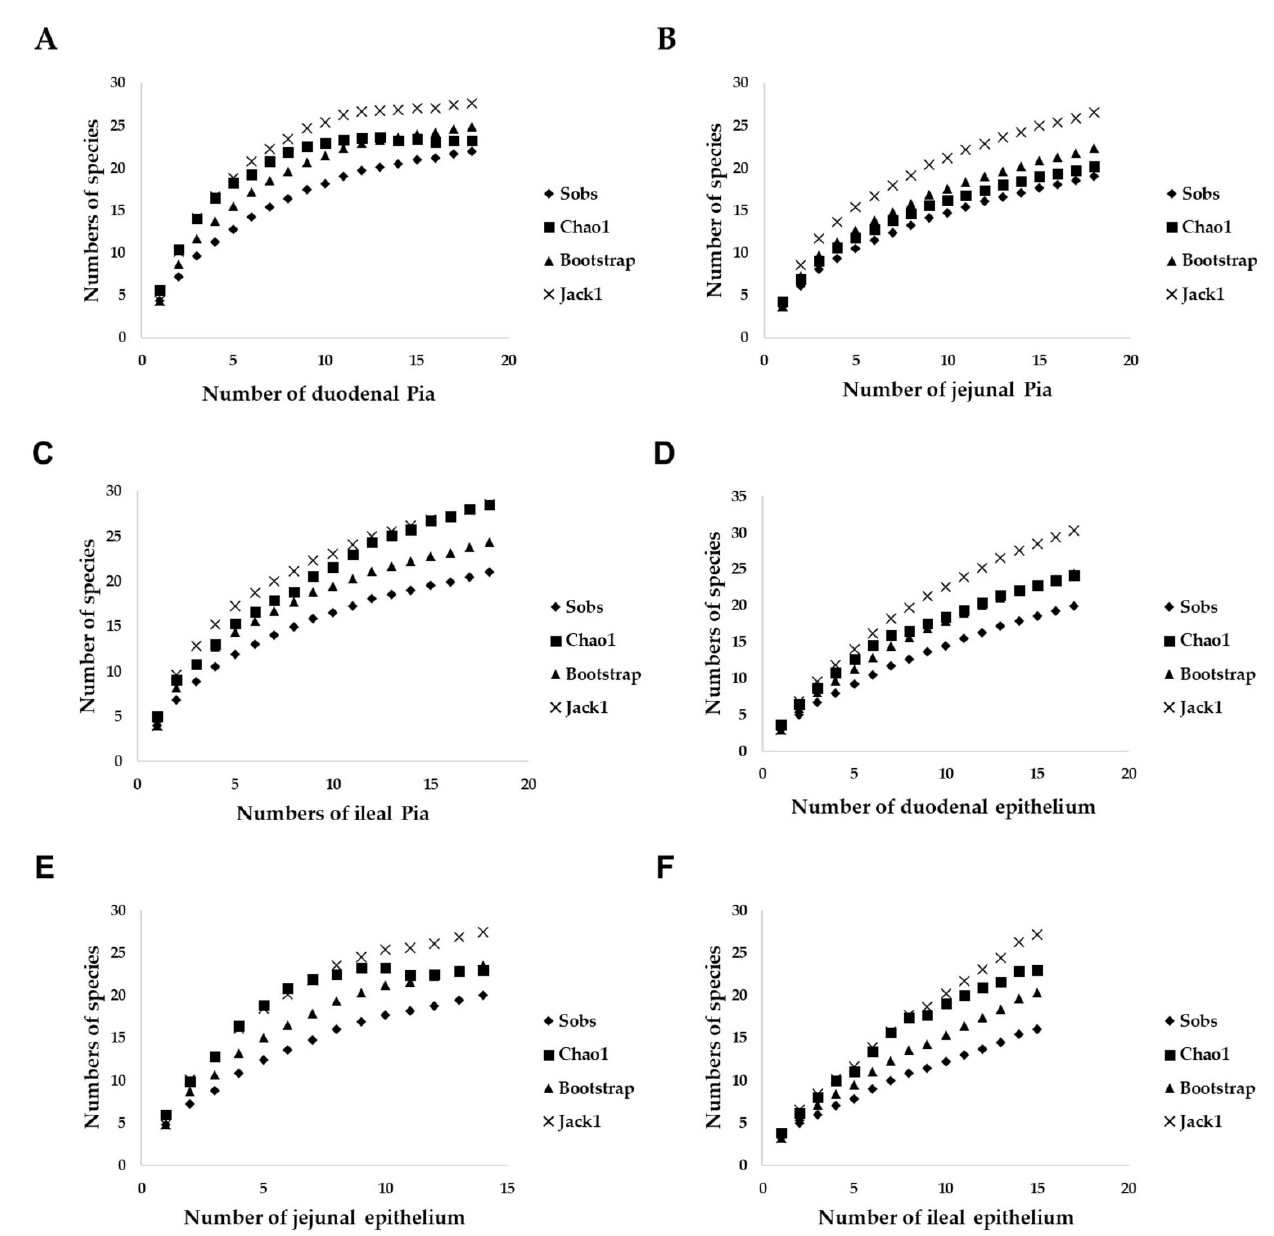
Figure 3. Species accumulation curves showing the relationship between the number of pia or epithelial samples and the number of species observed (sobs). Chao 1, Jack 1 and bootstrap species richness estimators were plotted: ( A ) yeasts from duodenal pia, ( B ) yeasts from jejunal pia, ( C ) yeasts from ileal pia, ( D ) yeasts from duodenal epithelium, ( E ) yeasts from jejunal epithelium, and ( F ) yeasts from ileal epithelium.